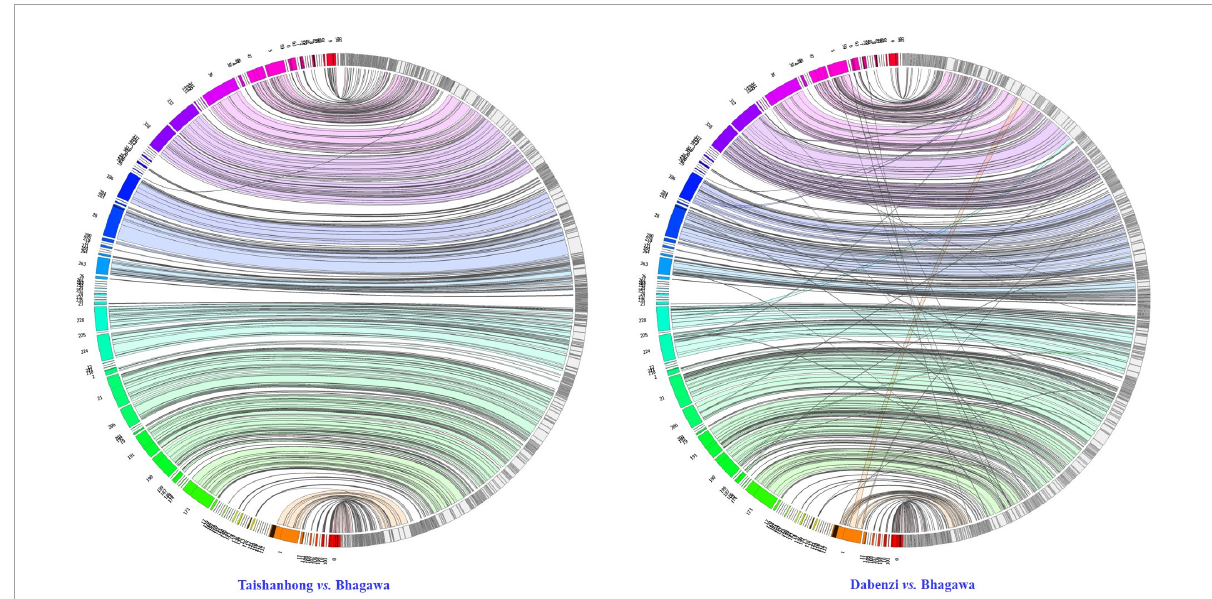
FIGURE4 Circos visualization of the syntenic relationship of ‘Bhagawa’ genome with the genomes of ‘Taishanhong’ and ‘Dabenzi’ pomegranate